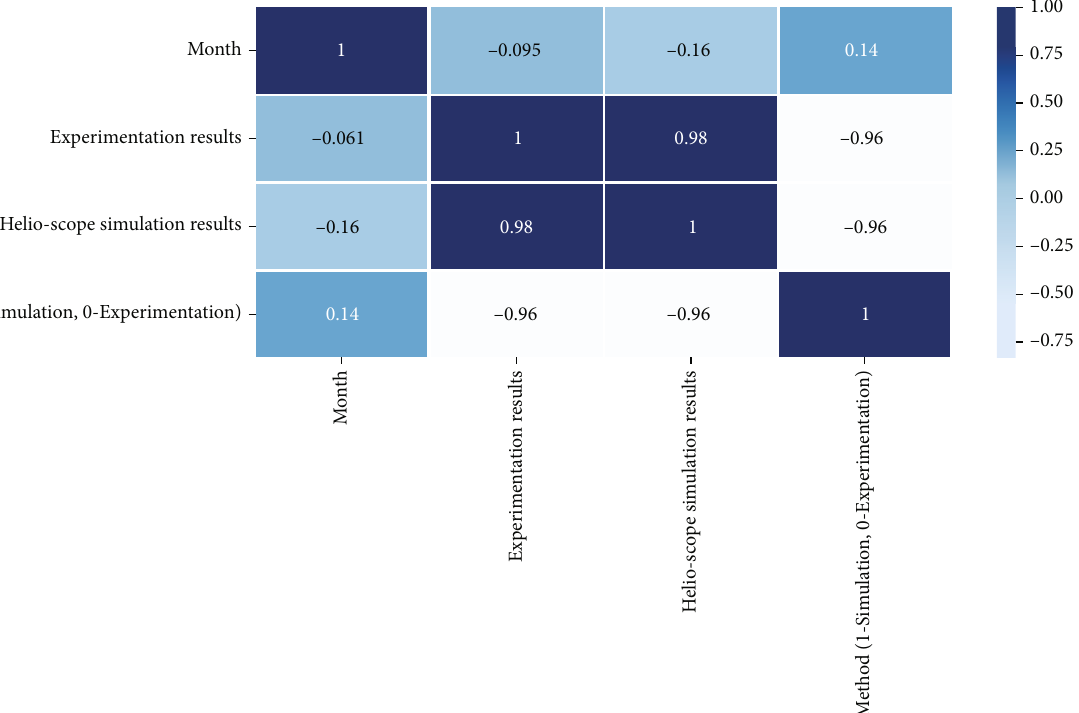
Figure 8: Heat map between each independent and dependent variable in the case of polyperk crystalline modules.